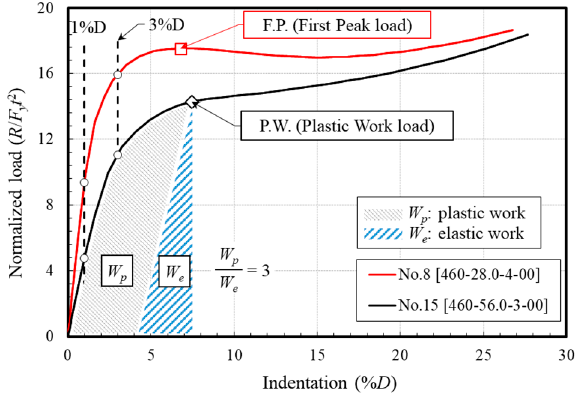
Figure 8. Definition of the deformation limit and maximum load.